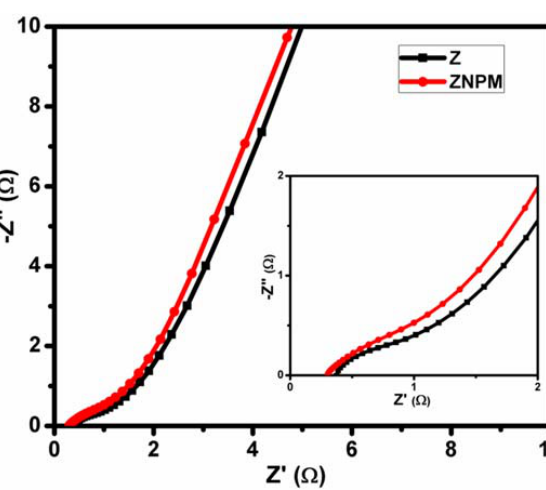
Figure 7. Electrochemical impedance spectroscopy of Z and ZNPM electrodes on nickel foam substrate. Inset shows the high magnified impedance plot.